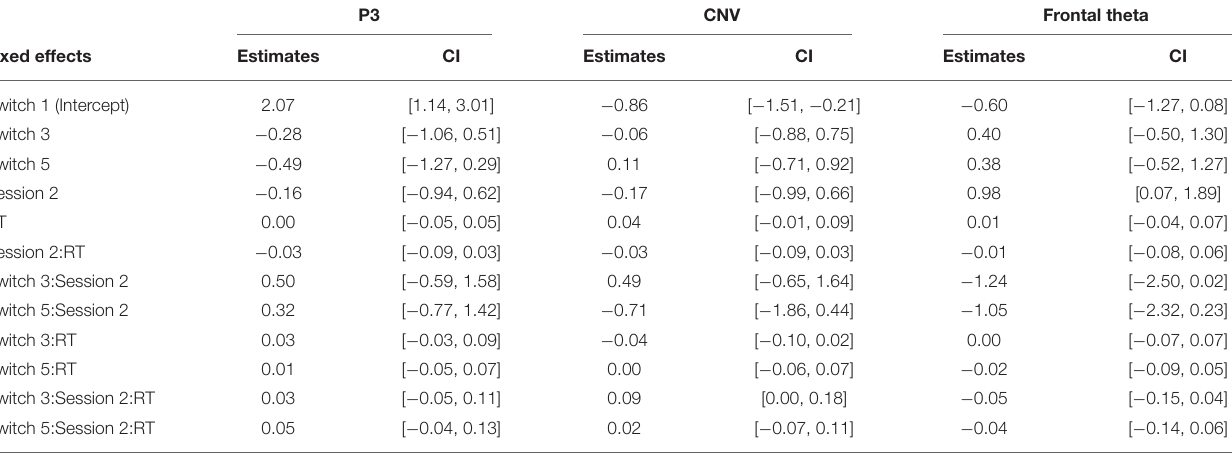
TABLE 4 | Estimated coefficients of fixed effects in LMEs for EEG responses relative to pre-cue.